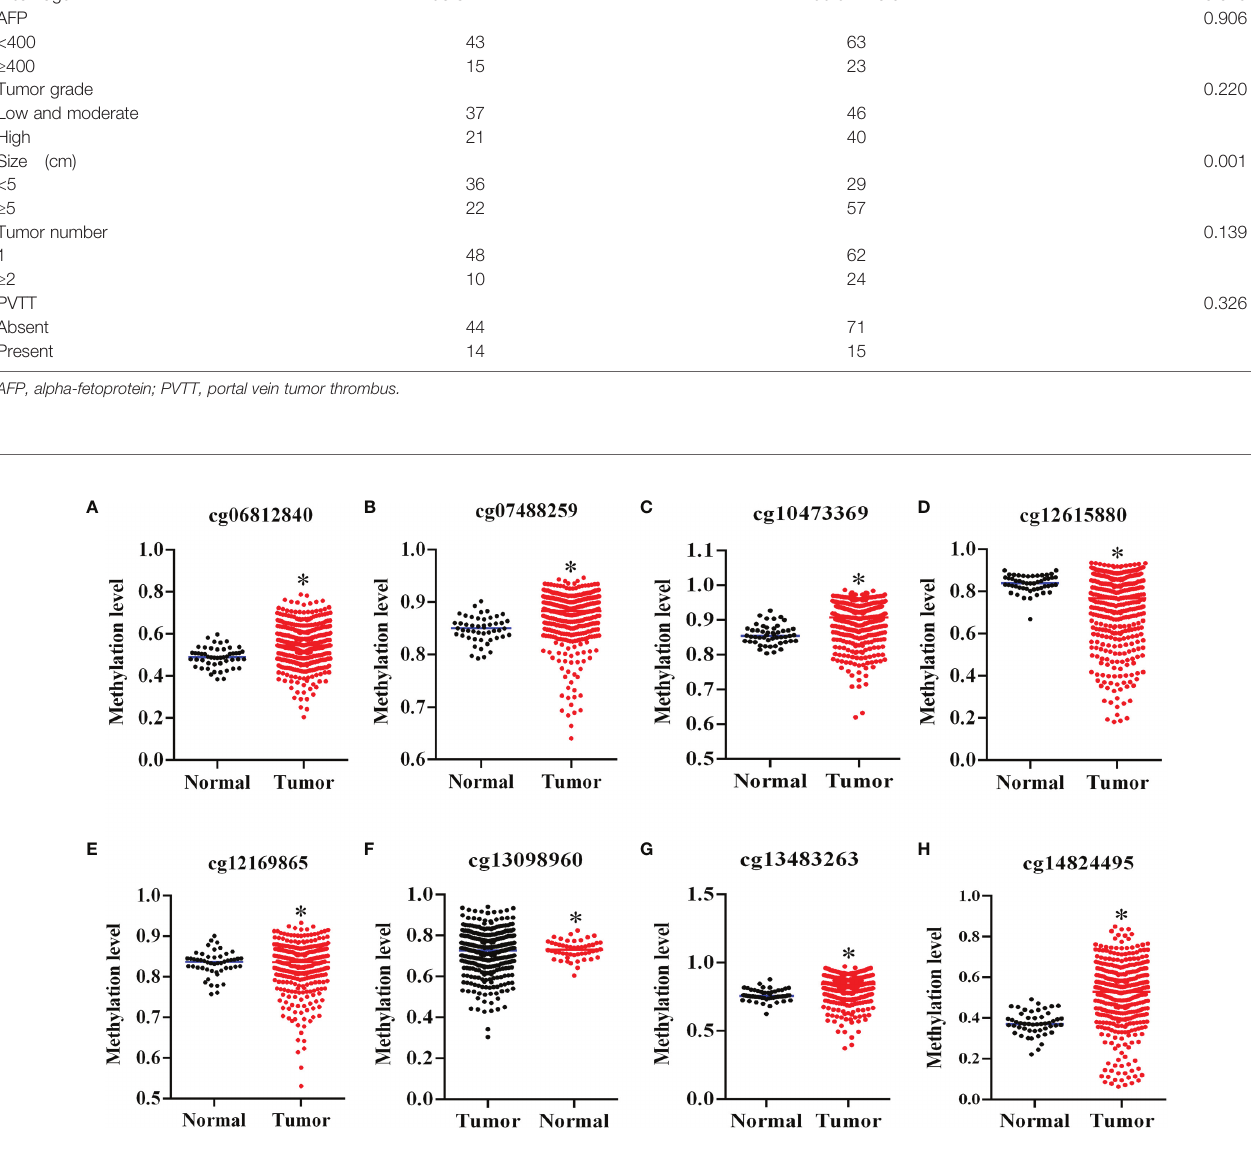
FIGURE 3 | Sox15 silencing was governed by promoter methylation in HCC. (A – H) Sox15 promoter methylation level in CpG sites in HCC detected through TCGA data. *p <